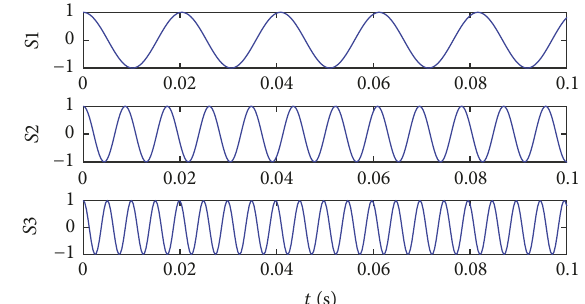
Figure 4: Time domain waveform of the selected source signals.